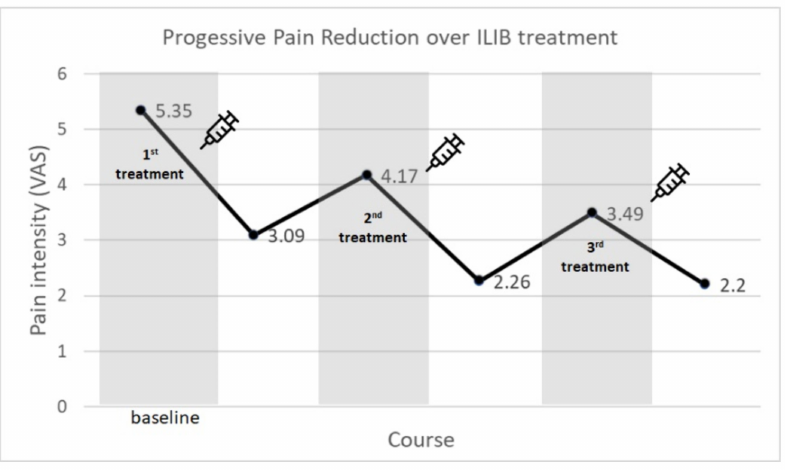
Figure 3. ILIB treatment showed the pain reduction effect over three courses of treatment. (VAS scale: